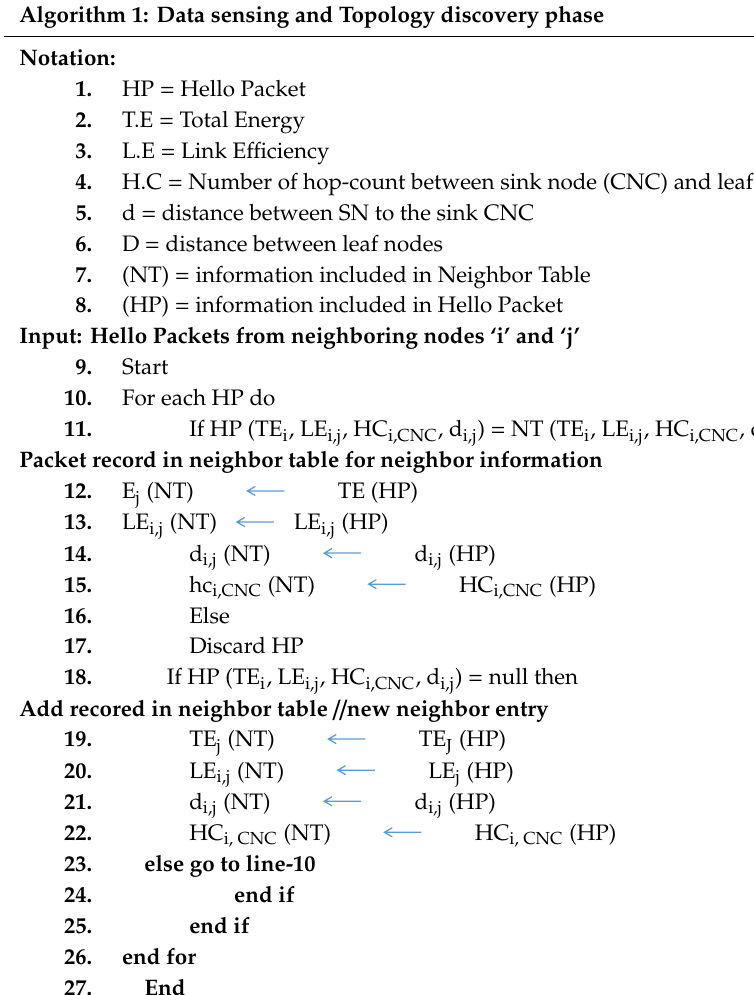
Algorithm 1: Data sensing and Topology discovery phase